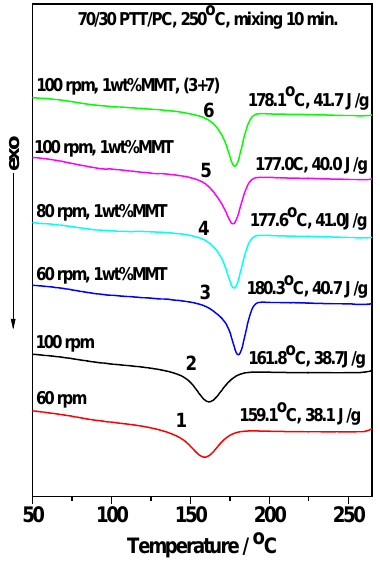
Figure 3. The influence of shear rate, MMT (Cloisite ® 25A) and processing mode on the crystallization of the 70/30 PTT/PC blend processed at 250 °C for 10 min. (3 + 7) signifies that PTT was mixed with MMT for 3 min and then added to the PC and mixed continuously for 7 min.